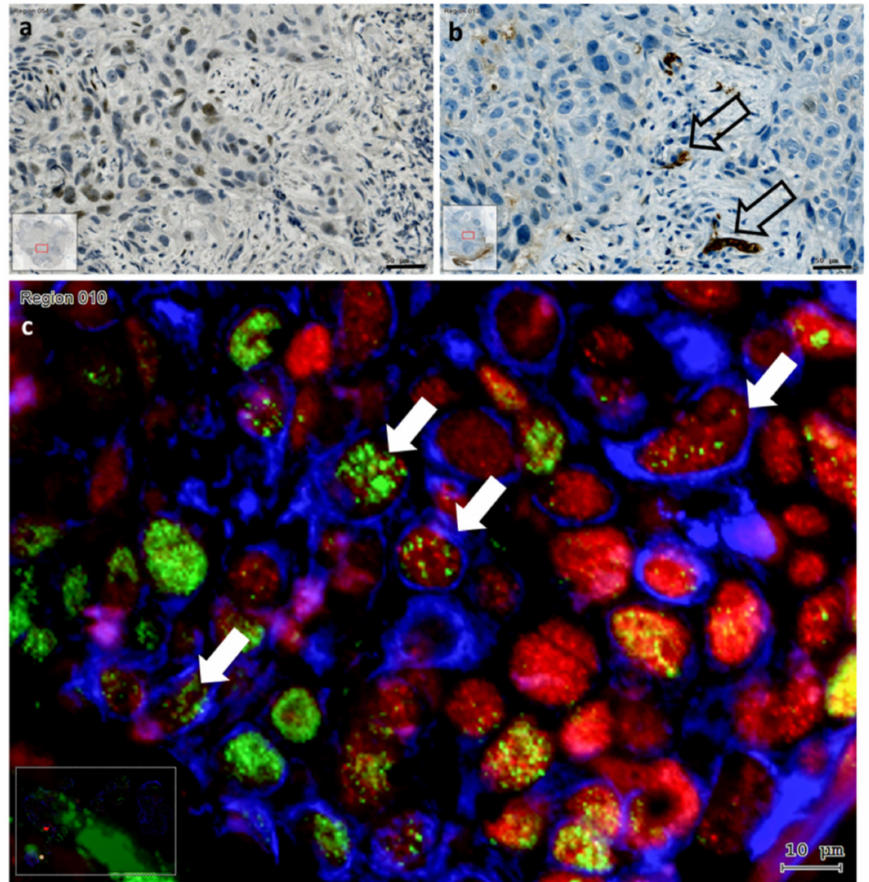
Figure 5. Comparison of enzyme immunohistochemical labeling of Slug ( a ) and TGF- β 1 ( b ) with immunofluorescence labeling of KLF4 (red), pan-cytokeratin (blue) and vimentin (green) combined ( c ) in HNSCC with p53 gain of function mutation. The Slug + cells formed a cluster in the cancer cell nest in the tumor-stroma interface ( a ). In this location scattered stroma cells, and at a lower extent also tumor cells reacted positively with antibody against TGF- β 1 (open big arrows) ( b ). Using increased magnification acquisition of the combined immunofluorescence labeling of CK, vimentin and KLF4 ( c ), more cells with combined CK, KLF4 and vimentin were detected ( c ) (white arrows). Bars: 50 µ m in brightfield and 10 µ m in fluorescence. The colors in fluorescence were chosen to present the co-localizations